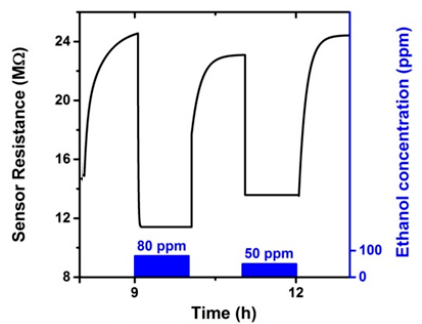
Figure 3. Sensor Resistance variation in front of ethanol diluted in SA with the operating at 200